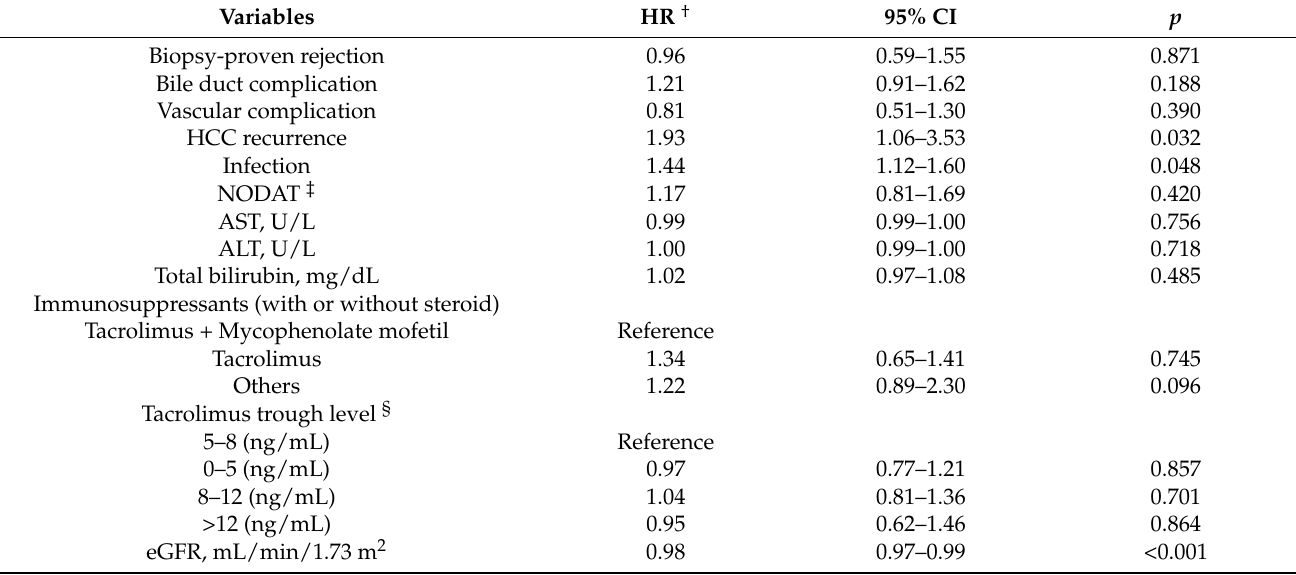
Table 3. Post-transplant risk factor analyses for CKD using time-dependent Cox model.